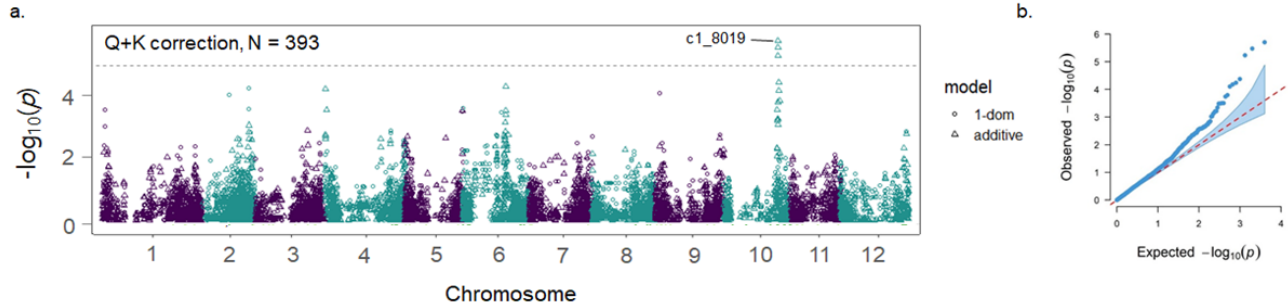
Figure 1. The genome-wide association analysis for 95 chip-processing cases and 298 controls. The plot represents the Q + K corrected-GWAS of chip processing for the 393-line panel ( a ). The x -axis shows the chromosomal position, and the y -axis shows the significance of association ( − log 10 ( p )). The dotted horizontal line shows the genome-wide significance level ( − log 10 ( p ) = 4.9) calculated by the Bonferroni method. In this study, we used the additive model and two simplex dominant models (1_dom_alt and 1_dom_ref). On the right is the quantile–quantile (Q–Q) plot for GWAS of additive model using 3977 SNPs for the 393-line panel ( b ). The area shaded in light blue indicates the 95% confidence interval under the null hypothesis.